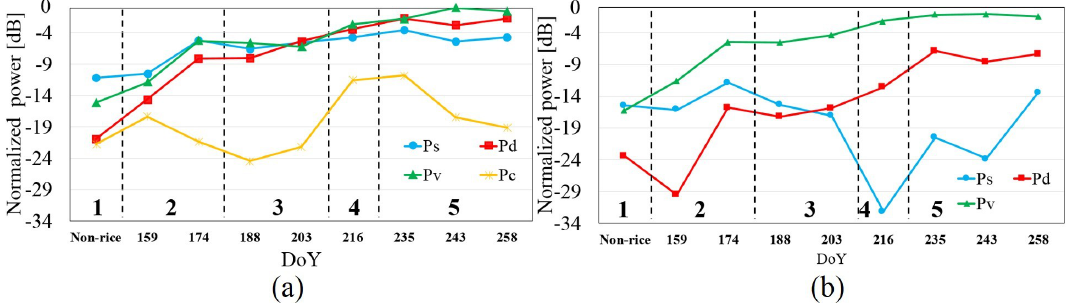
Figure 11. Four-/three-component decomposition results. ( a ) Four-component decomposition results for the FCP mode; ( b ) Three-component decomposition results for the DCP